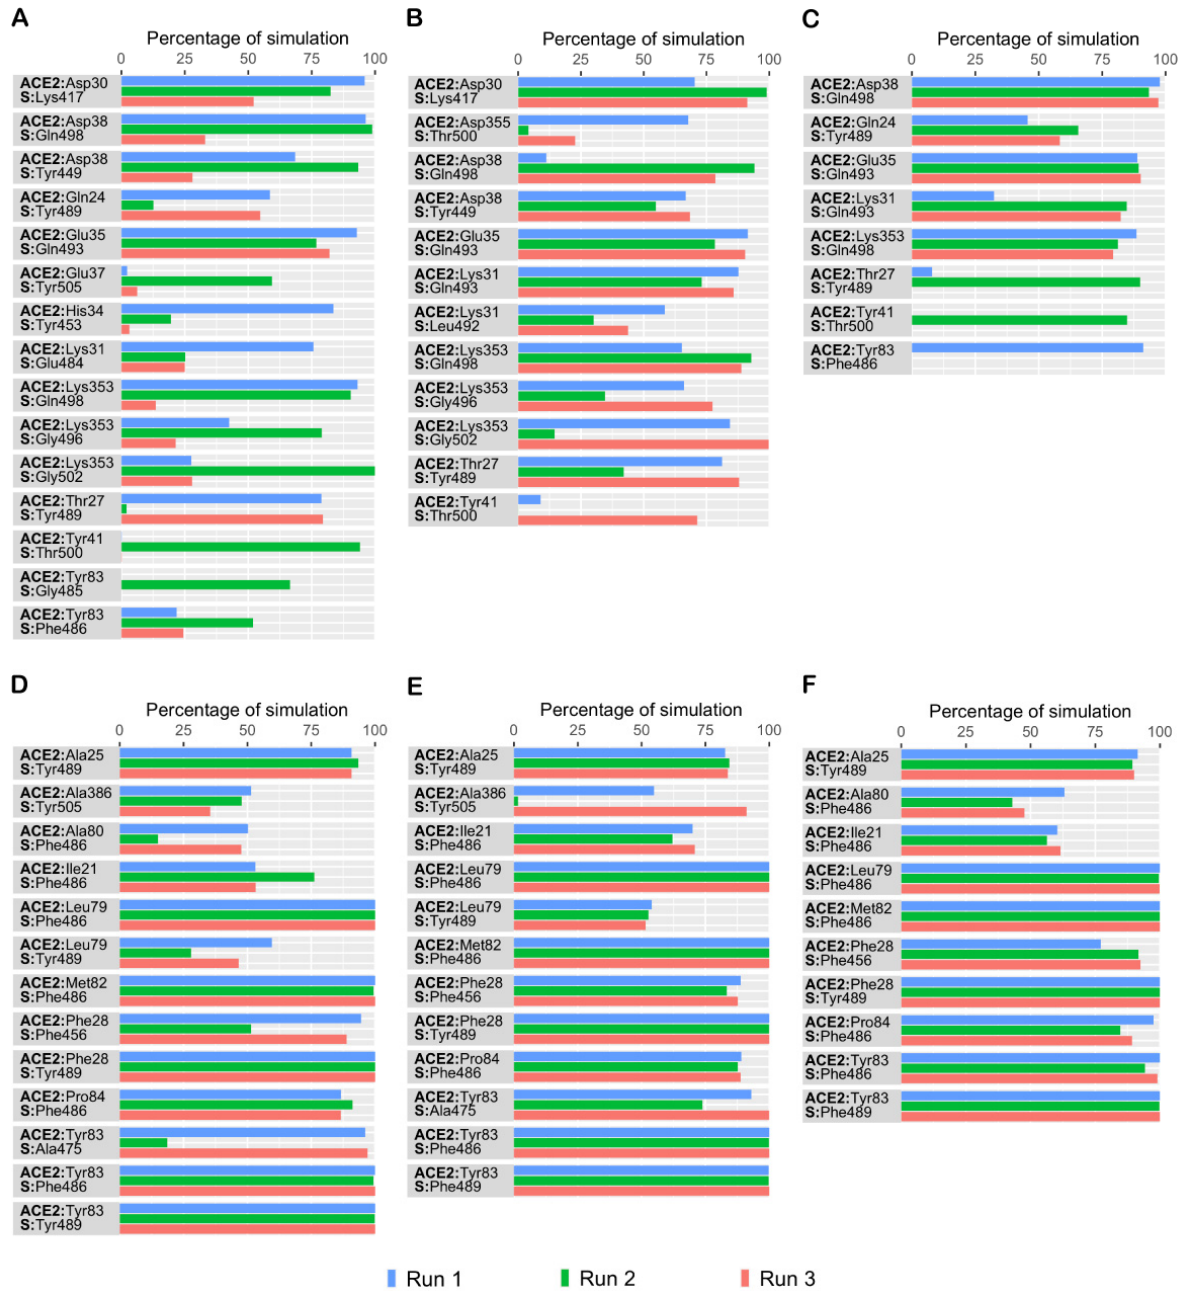
Figure 4. The percentage of simulation time during which intermolecular contacts were retained between human ACE2 (hACE2) and SARS-CoV-2 spike (S) protein receptor-binding domain (RBD) residues. ( A ) Intermolecular polar contacts in the L452R mutant complex; ( B ) Intermolecular polar contacts in the E484Q mutant complex; ( C ) Intermolecular polar contacts in the double mutant E484Q + L452R complex; ( D ) Intermolecular hydrophobic contacts in the L452R mutant complex; ( E ) Intermolecular hydrophobic contacts in the E484Q mutant complex; ( F ) Intermolecular hydrophobic contacts in the double mutant E484Q + L452R complex.